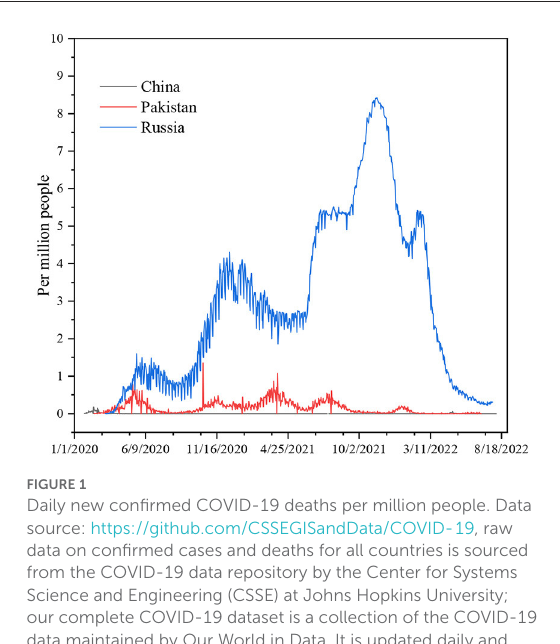
FIGURE1 Daily new confirmed COVID-19 deaths per million people. Data source: https://github.com/CSSEGISandData/COVID-19, raw data on confirmed cases and deaths for all countries is sourced from the COVID-19 data repository by the Center for Systems Science and Engineering (CSSE) at Johns Hopkins University; our complete COVID-19 dataset is a collection of the COVID-19 data maintained by Our World in Data. It is updated daily and includes data on confirmed cases, deaths, hospitalizations, and testing. Variable time January 27, 2020–August 20, 2022.